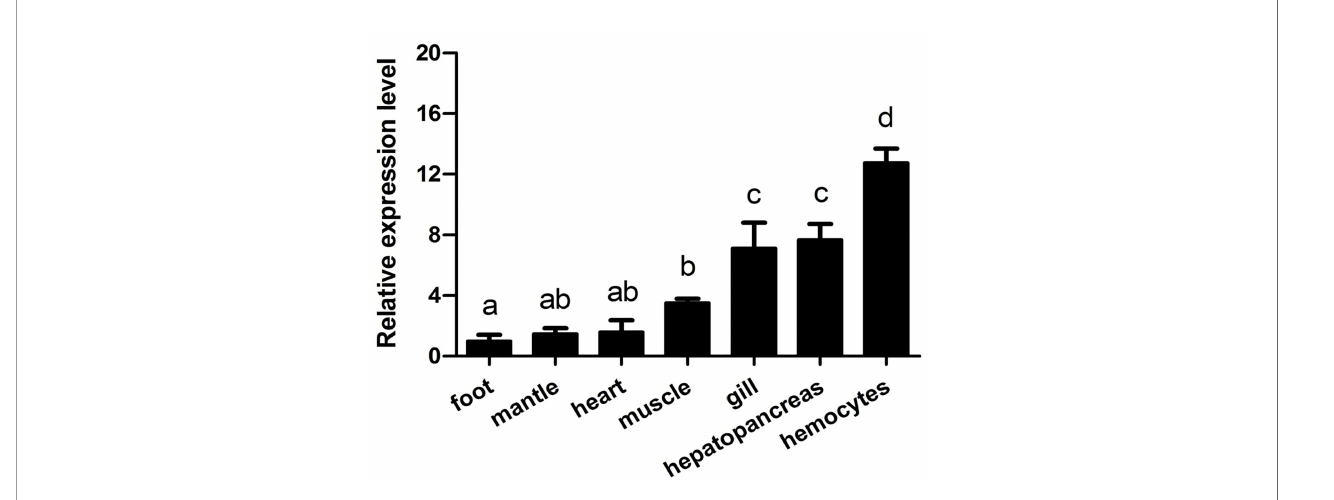
FIGURE 3 | Expression pro fi les of Aw MyD88 in different tissues of A. woodiana were determined by qRT-PCR. b -actin expression served as an internal control. The relative expression of Aw MyD88 is presented as the fold change for the foot. Data are shown as mean ± S.E. ( N = 3). Different letters above the bars indicate signi fi cant differences ( P <